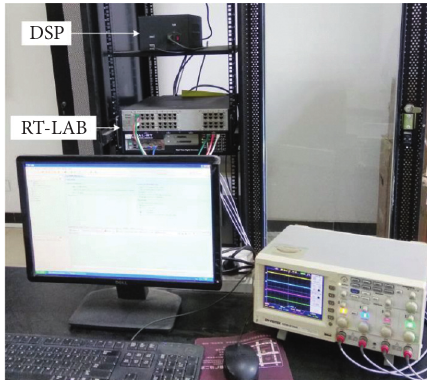
Figure 8: RT-Lab semiphysical experiment platform.